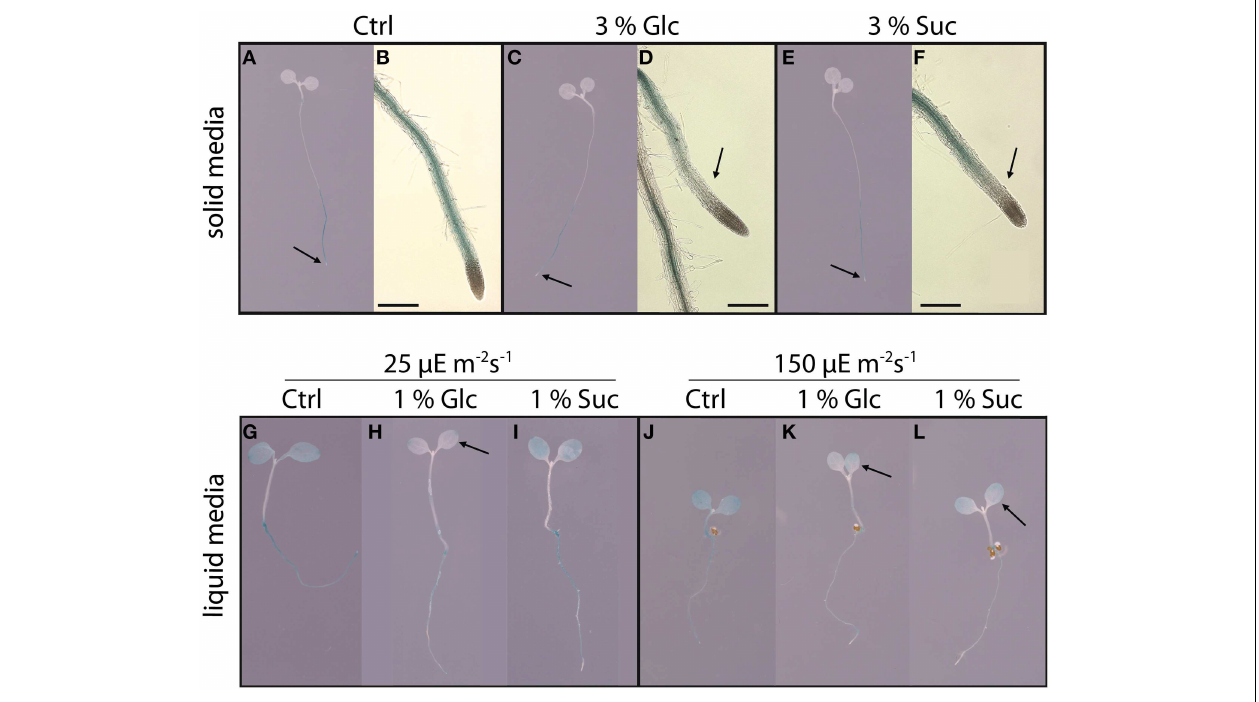
FIGURE 4 | Effects of growth conditions on sugar-dependent expression of bZIP63 in the pbZIP63::GUS line. The whole A. thaliana seedlings were grown for 7 days under a 16h light (either 25 or 150 µ mol m − 2 s − 1 )/8h dark photoperiod either on agar (A–F) or in liquid media (G–L) . Following a 24h dark-treatment, the seedlings were dipped for 6h either into water (controls A,B,G,J ), 3% Glc (C,D) , 3% Suc (E,F) , 1% Glc (H,K) , or 1% Suc (I,L) , and the